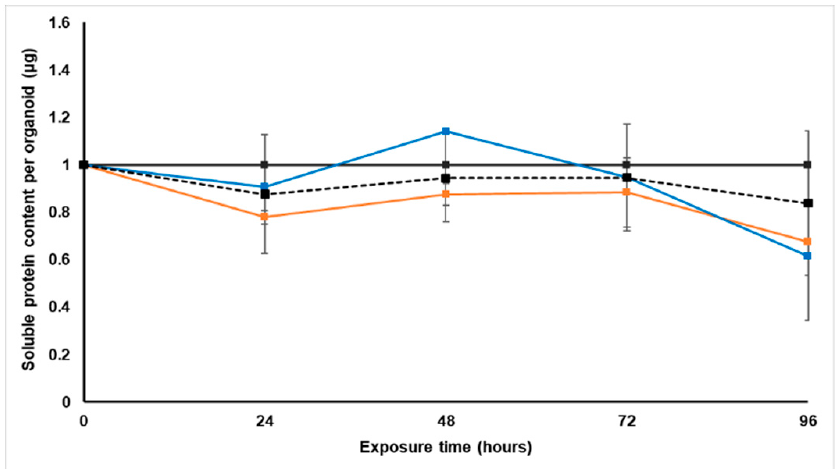
Figure 2. Normalized soluble protein content per spheroid ( µ g) of the sodium alginate encapsulated LS180 mini-tumor model, following 96 h exposure to Sutherlandia frutescens aqueous extract or paclitaxel. The solid black line represents the untreated control, the black dashed line represents paclitaxel [IC 50 ], the orange line represents S. frutescens [IC 50 ], and the blue line S. frutescens [IC 50 ]/2. All data were normalized to the untreated control group (error bars = standard deviation, n = 3 for S. frutescens [IC 50 ]/2 and n = 6 for S. frutescens [IC 50 ] and paclitaxel [IC 50 ]).